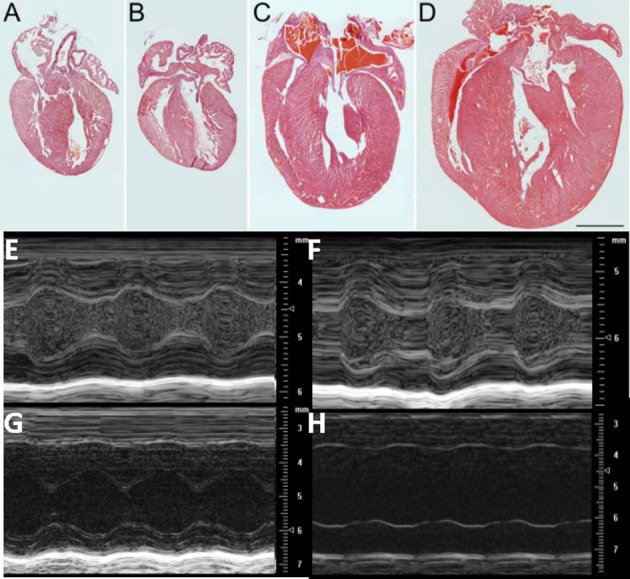
Morphologic and functional change in cMyBP-C−/− between PND 1 and PND9: Hematoxylin and Eosin (H&E) staining of representative sections from hearts of WT (A, C) and cMyBP-C−/−
(B, D) mice at PND1 (A,B) and PND9 (C,D). Scale bar = 1 mm. (E–H) Representative M-mode echocardiographic images of WT (n = 6; E,G) and cMyBP-C−/− (n = 7; F,H) mice at PND1 (E,F) and PND9 (G,H). Note different scales for PND1 vs. PND9. Measurements listed in Table 1. PND1 images show increased echogenicity within LV cavity due to nucleated red blood cells that are absent by PND9.